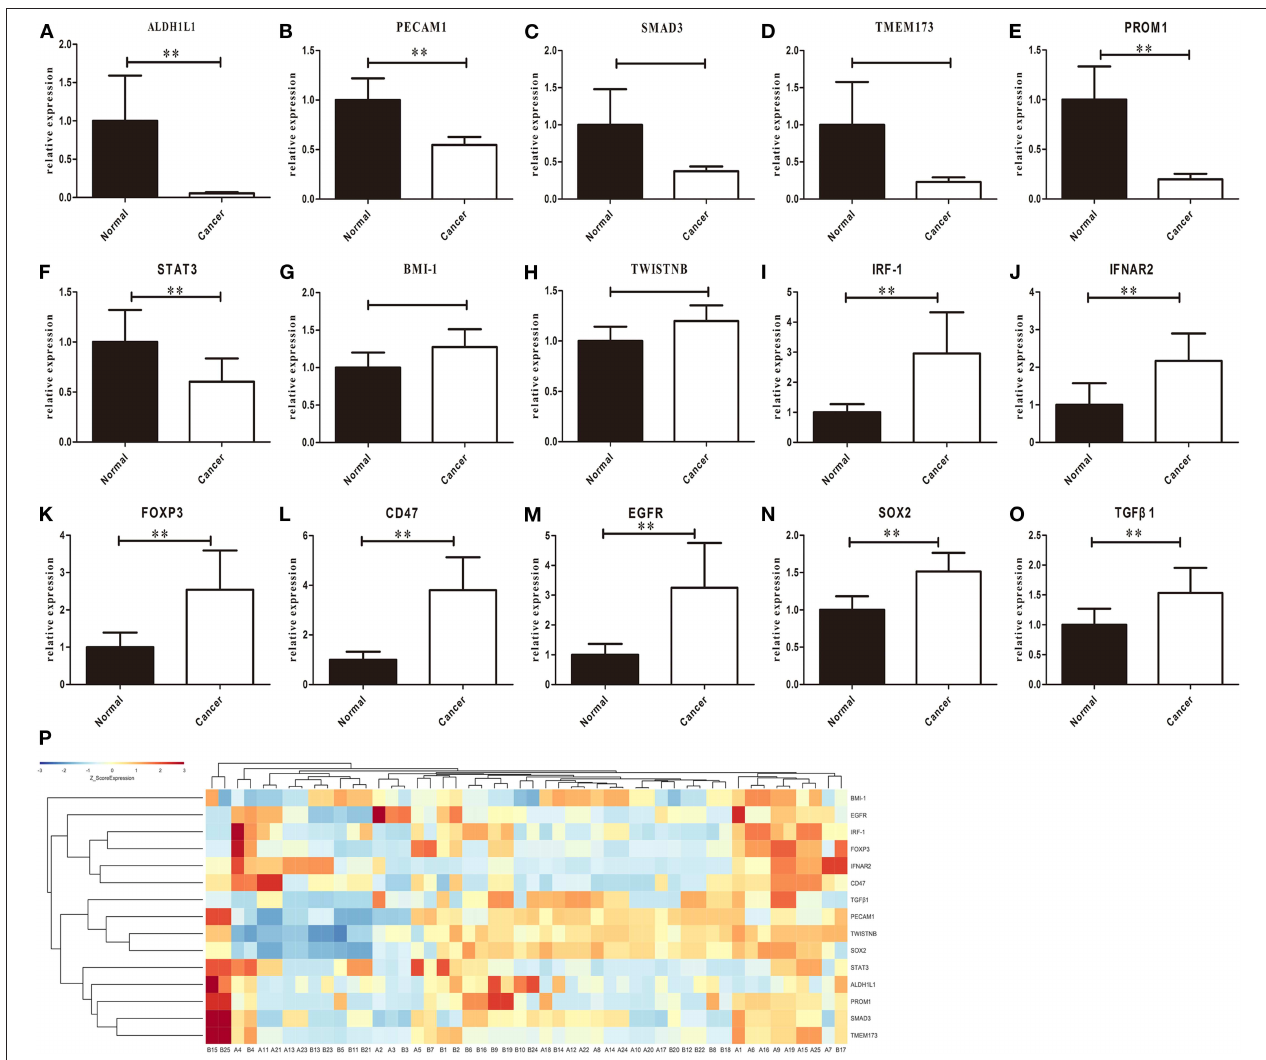
FIGURE 2 | RT-PCR results of ALDH1L1 (A) , PECAM1 (B) , SMAD3 (C) , TMEM173 (D) , PROM1 (E) , STAT3 (F) , BMI-1 (G) , TWISTNB (H) , IRF1 (I) , IFNAR2 (J) , FOXP3 (K) , CD47 (L) , EGFR (M) , SOX2 (N) , and TGF β 1 (O) expression in primary tumors. Each bar represents the average log2 gene mRNA expression level of the paired tumor and adjacent normal tissues ( n = 25 per group). Eleven genes showed significant changes between paired tumor and adjacent normal tissues (P) Heatmap of gene expression profiles of HNSCC patients in the primary of HNSCC, Gene expression values are calculated based on the log transform of FPKM values determined from RNA sequencing analyses. High expression is depicted by red; low expression is depicted by green, normalized by row z scores (legend) (** p < 0.05, t